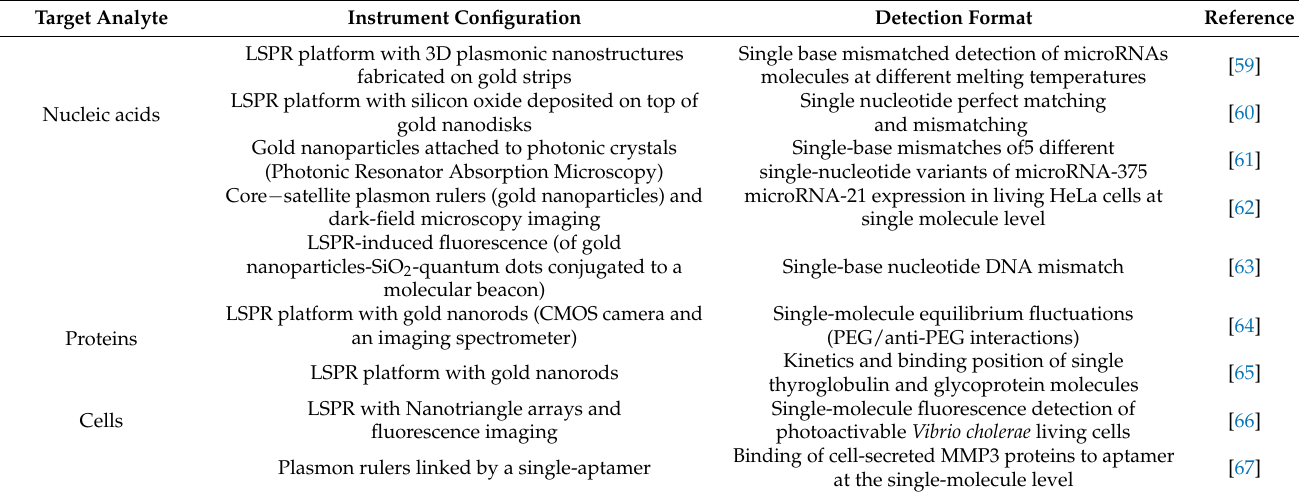
Table 2. Key analytical features of plasmonic nanoparticle-based sensors classified according to the characteristics of target analyte, instrument configuration (namely sensing scheme or biological receptor) and detection format. Target Analyte